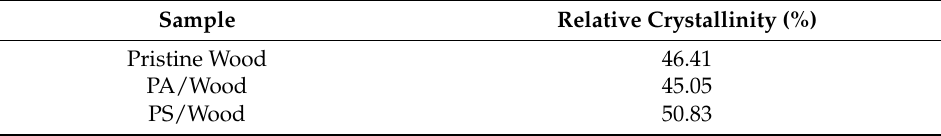
Figure 4. XRD patterns of the wood samples. Table 2. Relative crystallinities of the wood